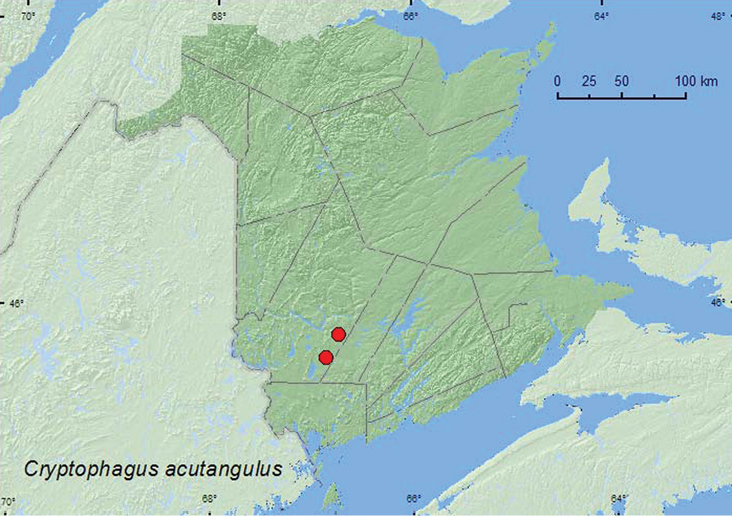
Collection localities in New Brunswick, Canada of Cryptophagus acutangulus.